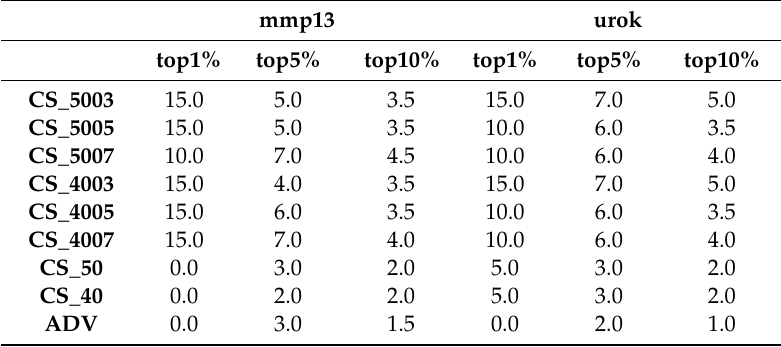
Table 5. Enrichment factor values obtained in the virtual screening tests carried out on mmp13 and urok using the di ff erent contact frequency datasets and AutoDock